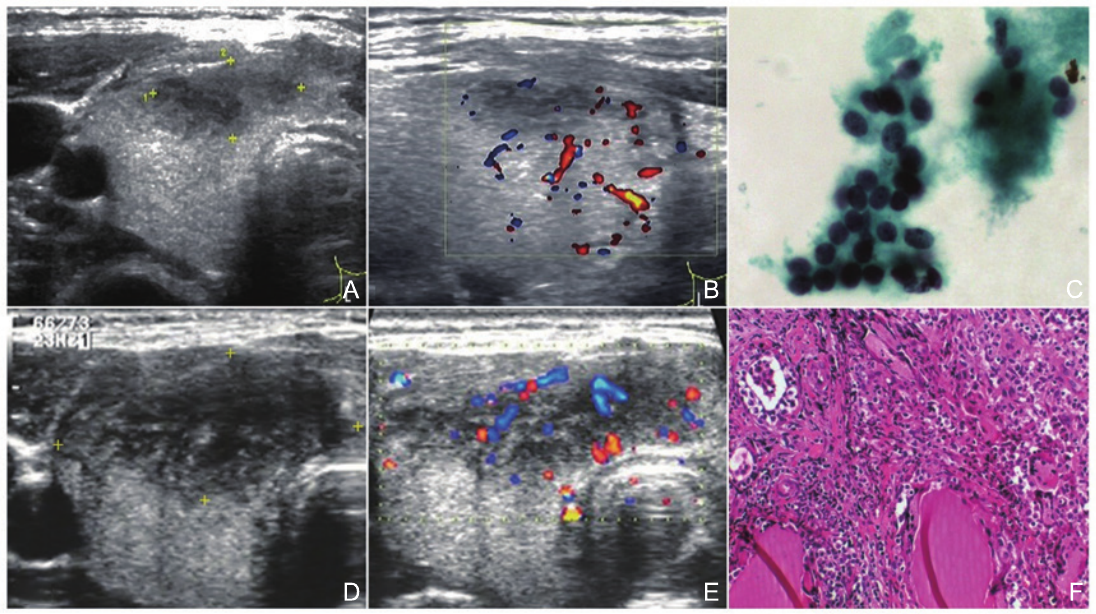
Figure 1 US showed a 17×8×24mm nodule in the right lobe of thyroid showing a heterogeneous, hypoechoic area with indistinct margin (A, +) and lack of color flow (B) before fine-needle aspiration (FNA). Cytological analysis reported Bethesda II (benign), showing benign follicular cells (C). US showed obviously enlargement of the right-sided nodule (34×13×33mm) spreading to the isthmus (D, +), with increased of color flow (E) 12 days after FNA. Histological examination revealed subacute thyroiditis